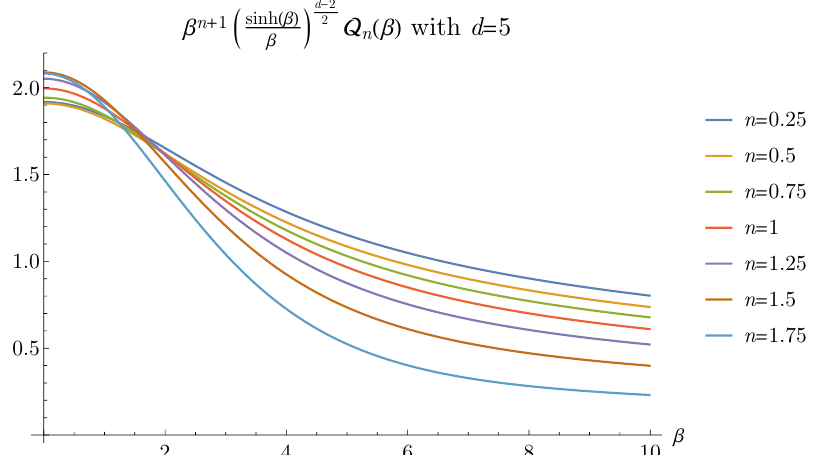
) d − 2 ( β ) in d = 5 for various values of n . In each case, it is 2 Q n β